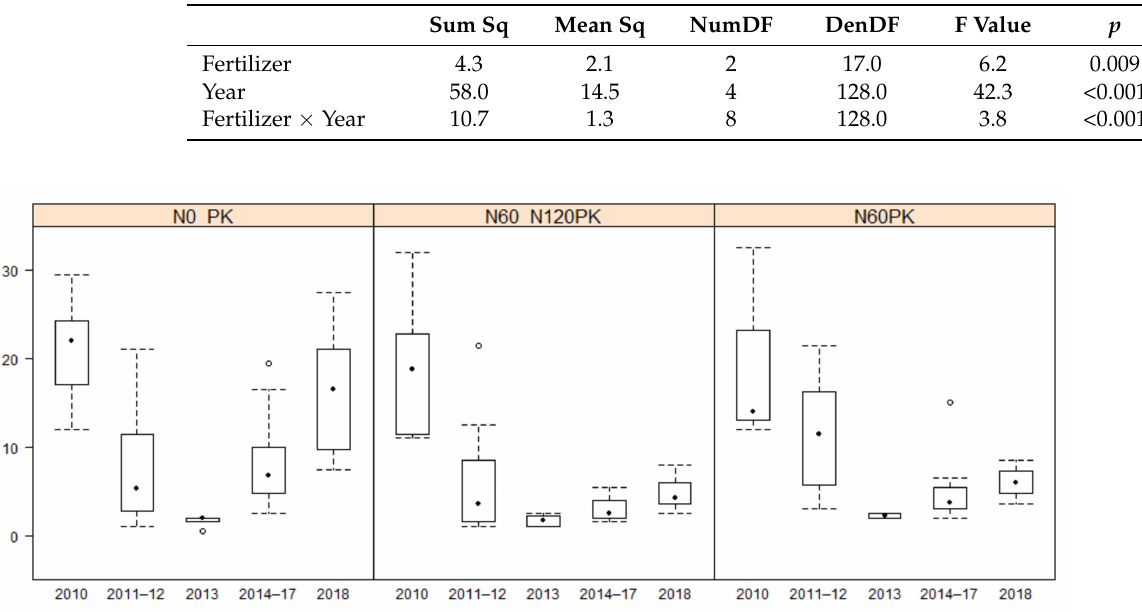
Table 7. Effects of fertilizer and year on the cumulative cover of legumes according to the minimal